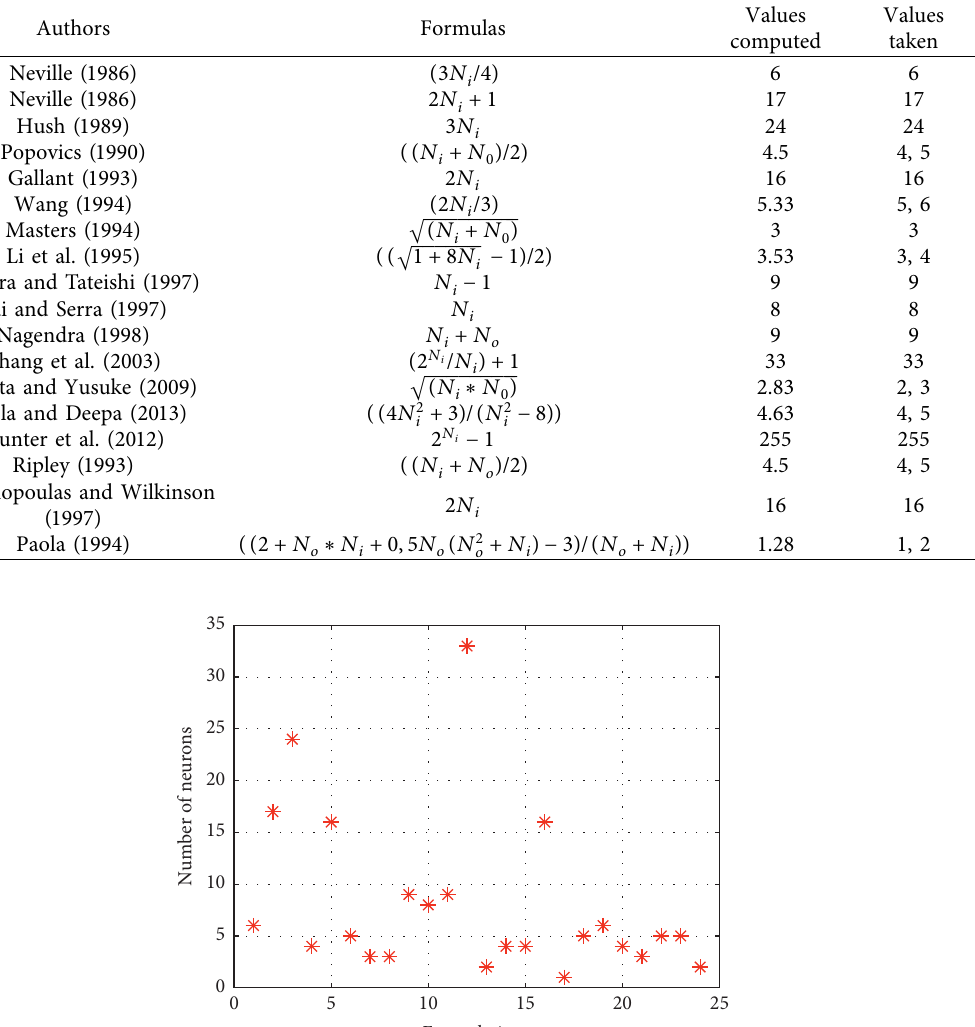
Table 2: Summary of different values of neurons in the hidden layer proposed in the literature.